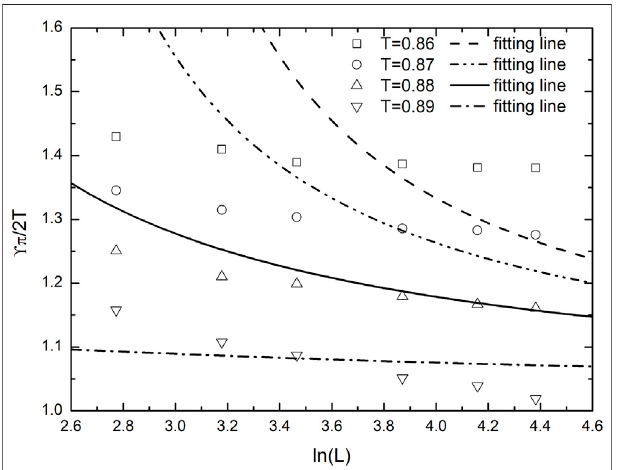
FIGURE 4 | Vortex density ρ for q (cid:1) 5 ,